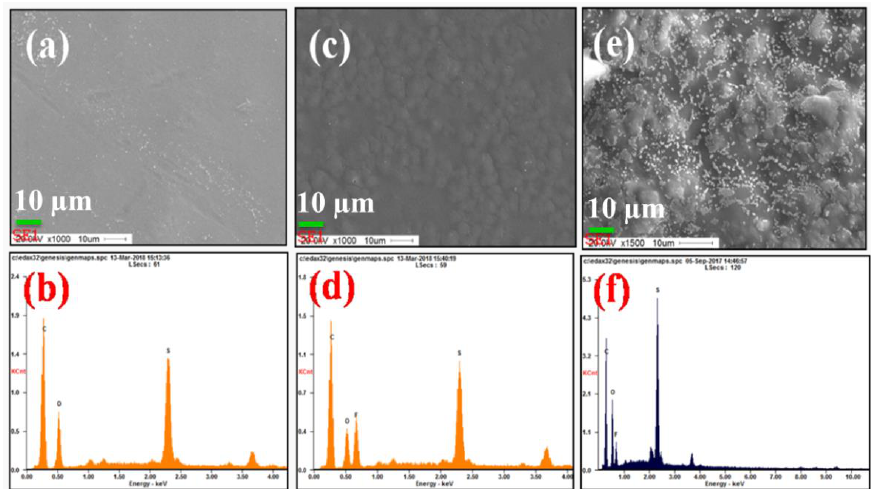
Figure 3. FE-SEM images of membranes of ( a ) X;( b ) XY; ( c ) XYX; and ( d ) YXY.